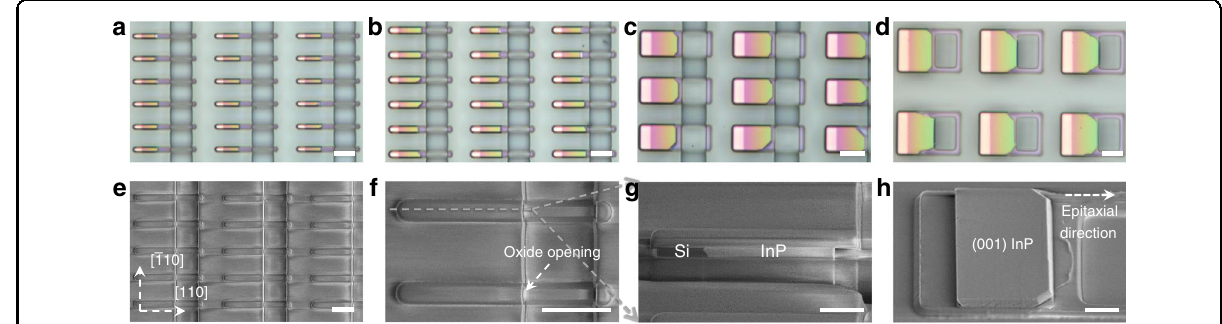
Fig. 2 In-plane InP sub-micron wires and membranes selectively grown on (001) SOI. a – d Optical microscope images of as-grown InP array with different pattern length: 500 nm, 1 µm, 5 µm, and 10 µm, respectively. Scale bar of a – d , 5 µm. e , f Top-view SEM image of as-grown sample at 1 µm patterned length area. Scale bar of e , f , 5 µm. g 52° tilted cross-sectional SEM image after focus-ion-beam cutting showing the in-plane InP laterally grown from Si. Scale bar, 2 µm. h 52° tilted SEM image of InP membrane grown by 10 µm pattern length after top oxide and Si removal.